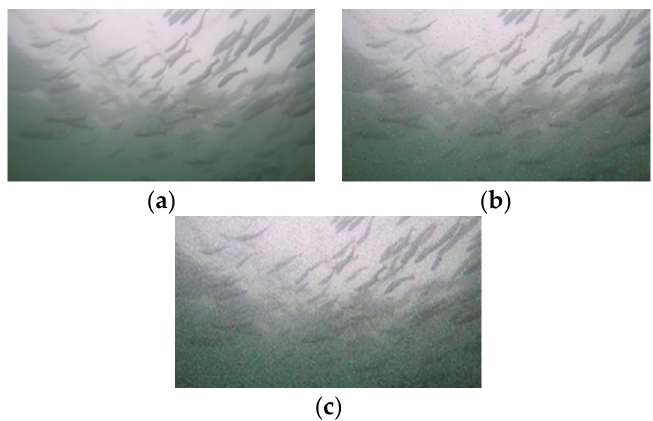
Figure 3. Original image and noisy images: ( a ) original image, ( b ) salt-and-pepper noise image, and ( c ) Gaussian noise image.